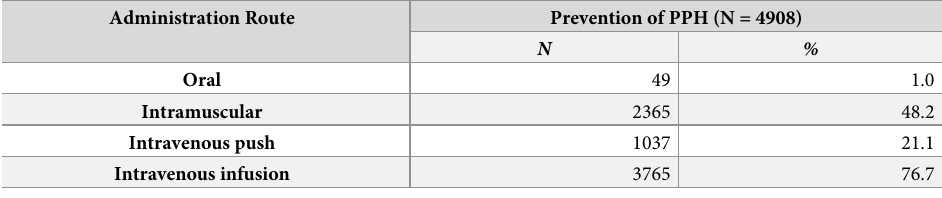
Table 4. Respondents’ � practice around route of administration of oxytocin for prevention of